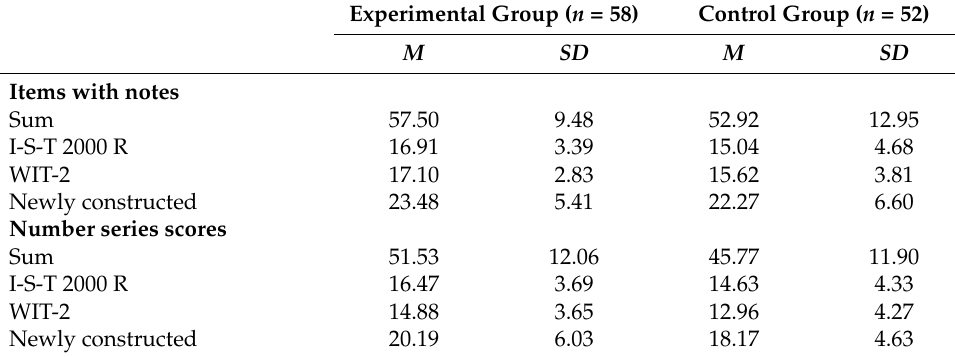
Table 1. Descriptive statistics for the number of items with notes and the number series